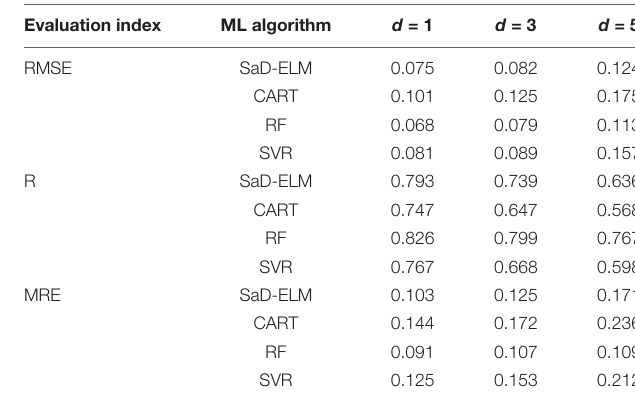
TABLE 4 | RMSE, R, and MRE of SIC prediction with different predictors. TABLE 5 | Predicted results with different ML algorithms and lead